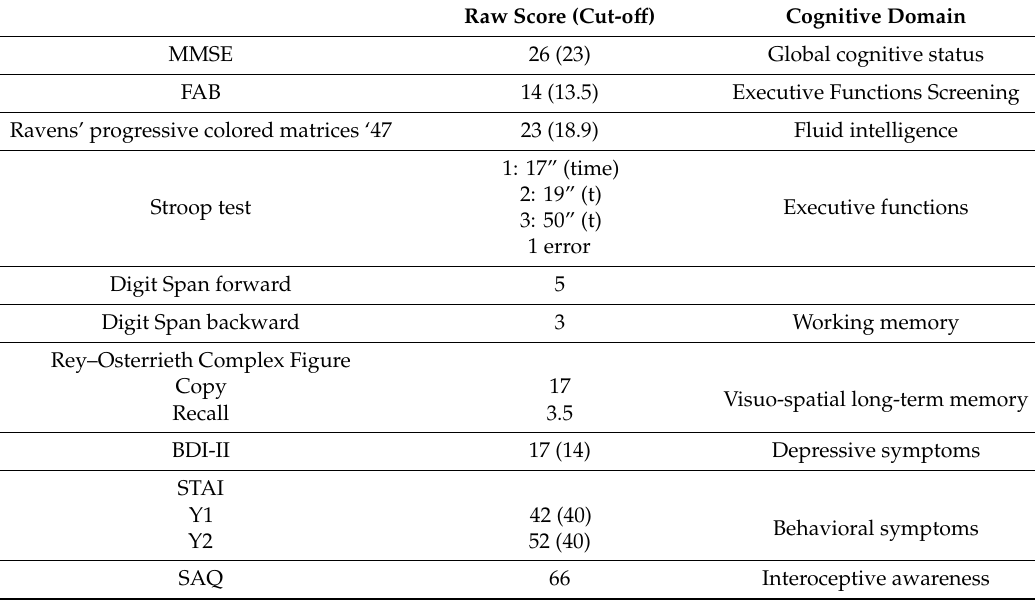
Table 1. Summary of clinical and cognitive results.